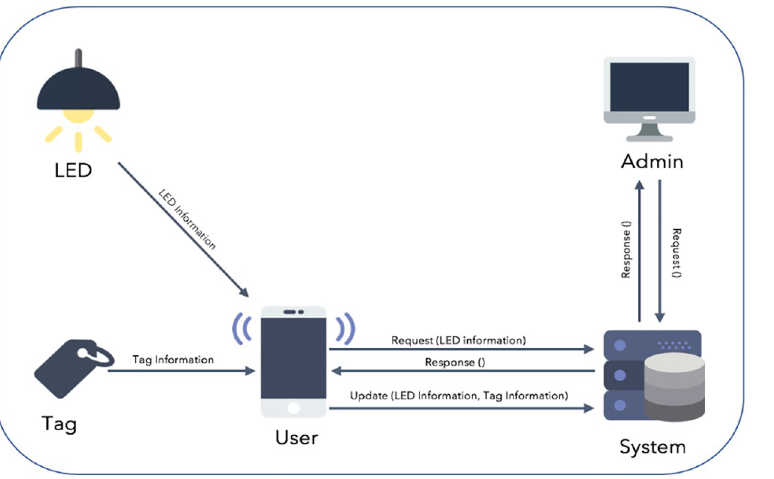
Fig 1. The proposed